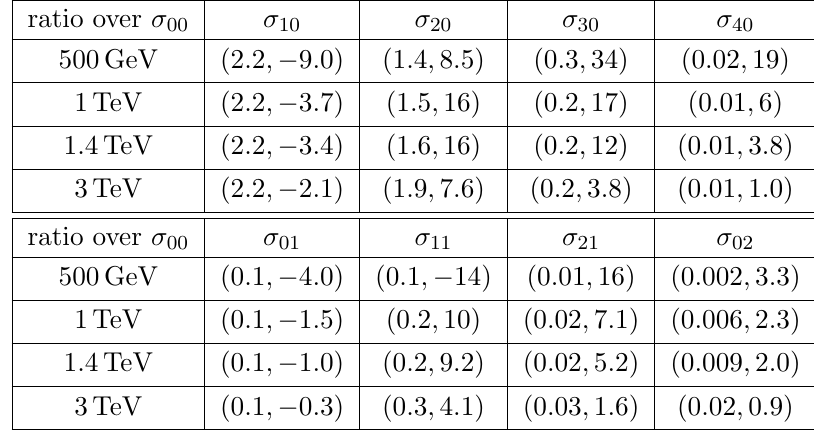
Table 2 . (cid:27) ij =(cid:27) 00 ratios for ( ZHHH , WBF HHH ). (cid:27) ij are de(cid:12)ned in eq.